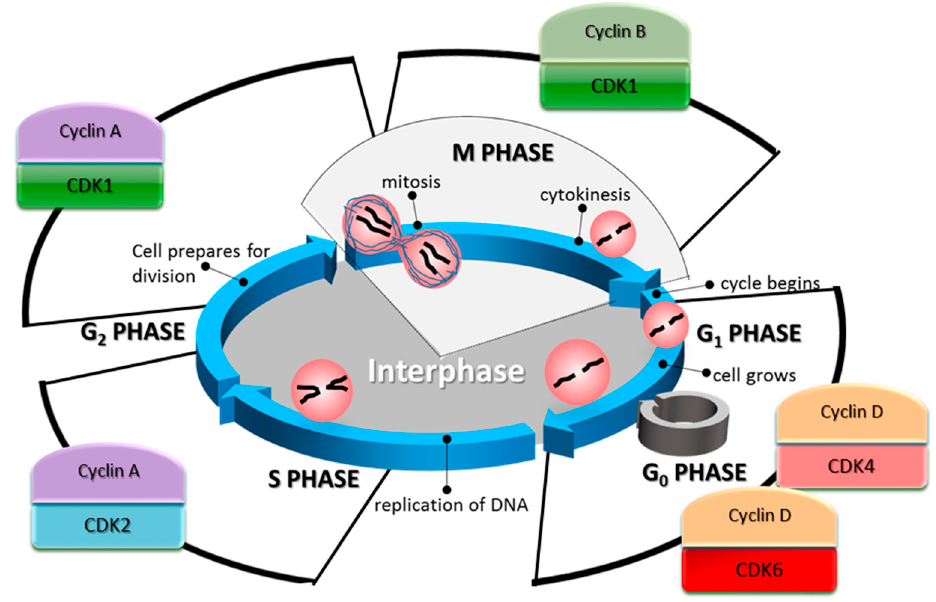
Figure 1. The cell cycle phases and their associated cyclin-dependent kinases (CDK)/cyclin complexes. In the G1 phase of the cell cycle, the synthesis of cyclin D is increased. This cyclin partners with CDK4/6 to promote cell cycle entry, and its progression through G1, as well as the G1/S transition. During the S phase, CDK2 in complex with cyclin A controls the phosphorylation of targets involved in DNA replication. Cyclin A is found highly expressed in this phase and until the last stages of G2. In the G2 phase, the primary regulator of the cell cycle is CDK1.